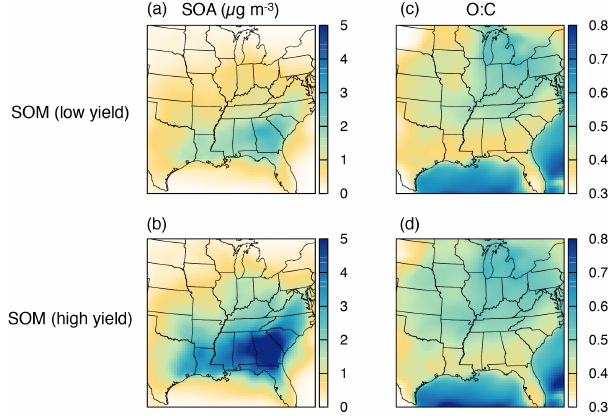
Figure 3. (a, b) 2-week averaged concentrations of SOA (in µgm − 3 ) and (c–d) 2-week averaged ratio of O : C for the eastern US. (a, c) are predictions from the SOM (low yield) simulations and (b, d) are predictions from the SOM (high yield)